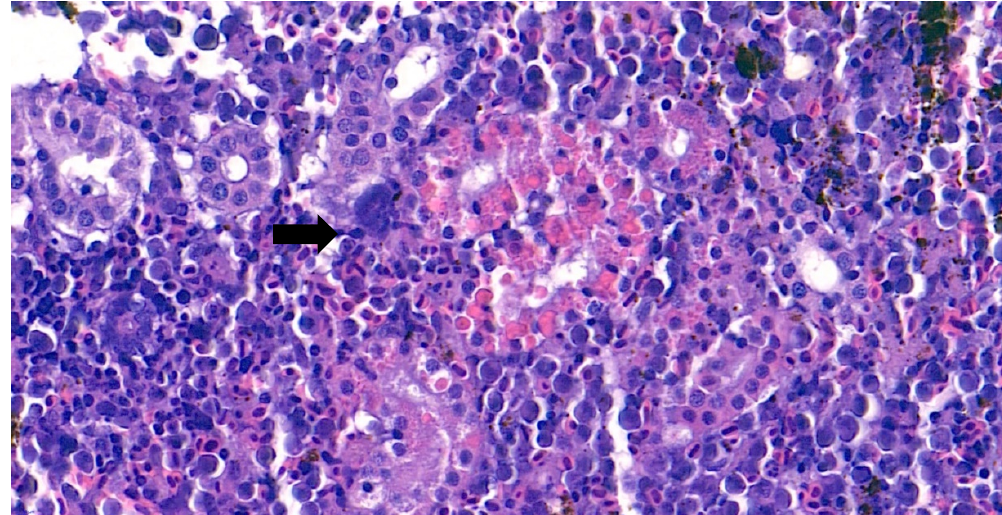
Figure 3. Representative image of hematoxylin and eosin-stained tissue section showing hyaline droplet accumulation in the tubular epithelium in the kidney of the diseased fish. Bacteremia can be observed in the area indicated by the arrow. (Bar indicating 10 µm).